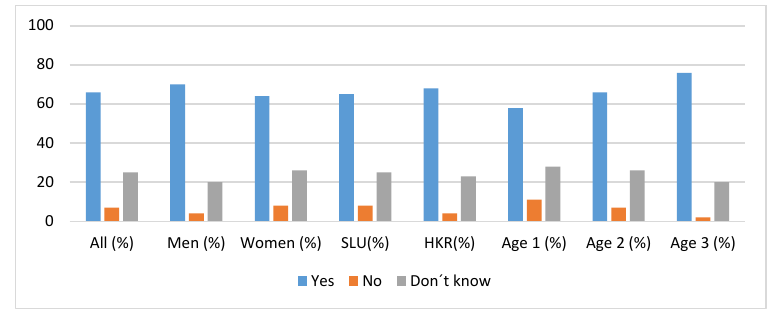
Figure 6. Preference of purchasing sites for heritage cereal products in the future. The category “Others” included the following options: Delivery to home/to work, REKO-ring, on-line/online store, directly from producer/grower, café, farm shop, bake yourself and market.